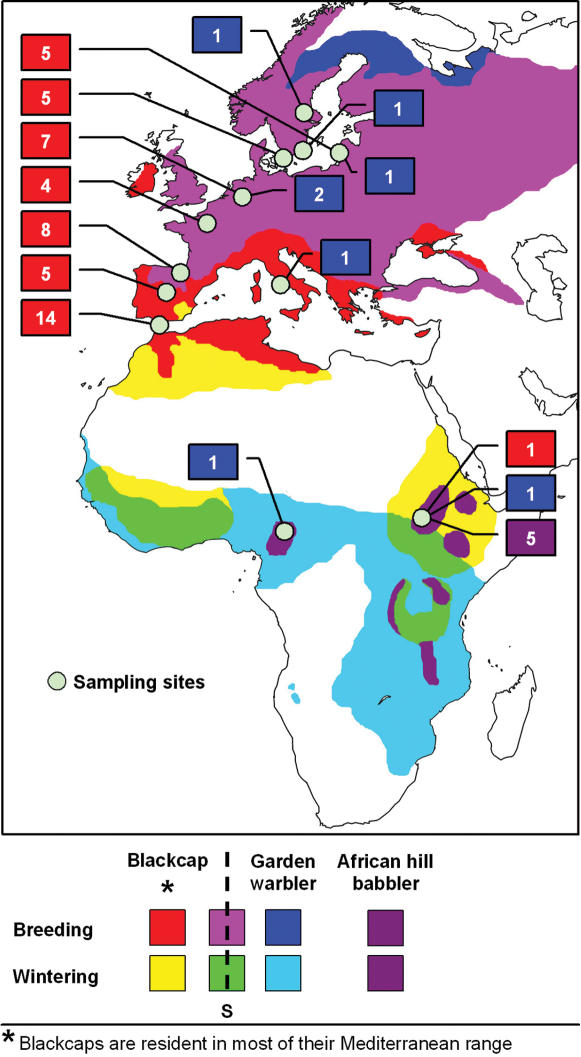
The geographic distribution of the parasite flock. The map shows the location of our sampling sites within the range of blackcaps, garden warblers and African hill babblers, which are shadowed in different colours according to the key below the map. Blackcaps and garden warblers are sympatric (S) in wide areas of Europe and Africa, during the breeding season and in winter, respectively. African hill babblers are year-round residents. Many blackcaps and garden warblers from Europe spend the winter in the range of African hill babblers, where the three species occur in the same habitat. For each sampling site, the squares indicate the number of parasite lineages from the flock that were found in each species (blackcap parasites in red, garden warbler parasites in blue, and hill babbler parasites in purple).